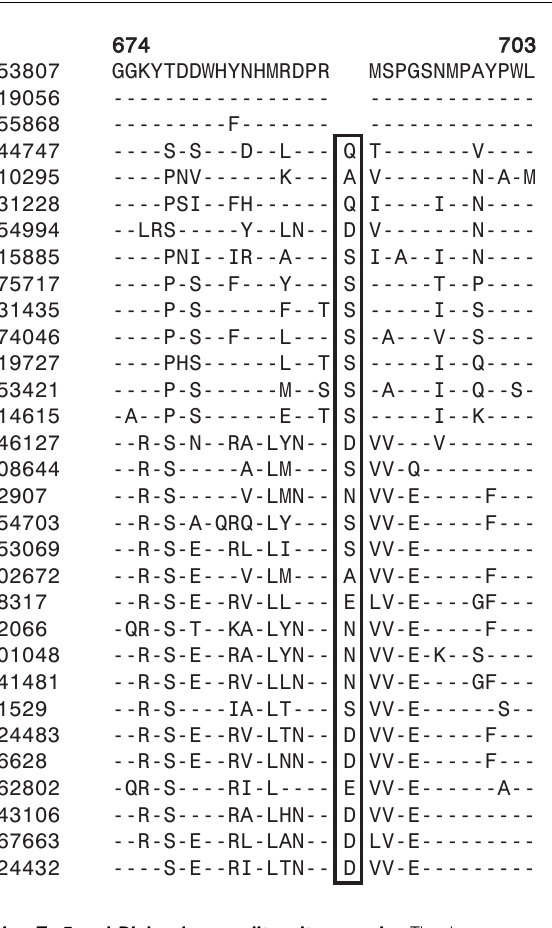
FIGUREA2 |A 1 aa deletion in a conserved region in the Cytochrome c oxidase protein is shown in this partial sequence alignment with the deletion specific for Opitutaceae bacteriumTav1 , Opitutaceae